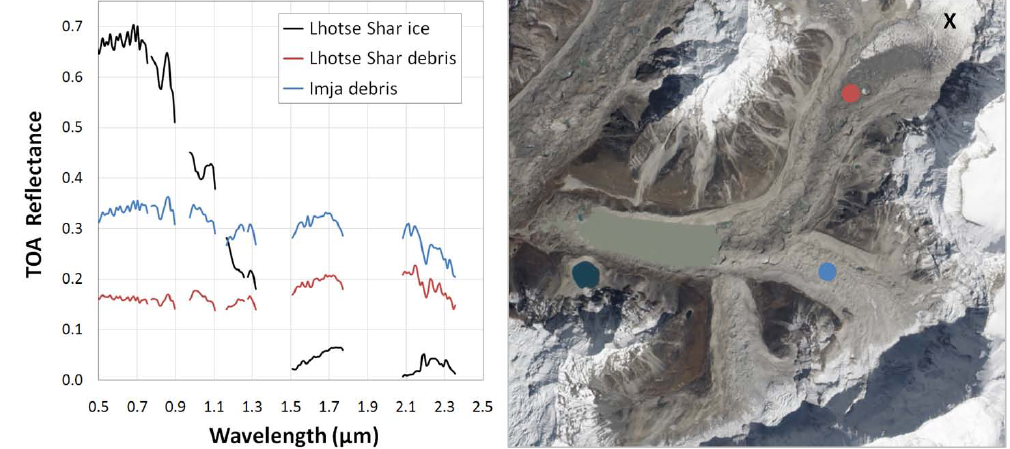
Fig. 4. Hyperion (13 May 2002) top-of-atmosphere supraglacial debris and ice reflectance plot (left) is displayed with a true color ALI (4 October 2010) 10m pan-enhanced image of the Imja and Lhotse Shar glaciers. Atmospheric water vapor, oxygen and carbon dioxide absorption features were removed from the reflectance signatures. The locations of the Hyperion derived spectra for debris are indicated by the blue (Imja glacier debris) and red (Lhotse Shar glacier debris) dots and the Lhotse Shar lightly dust covered ice by the black X.